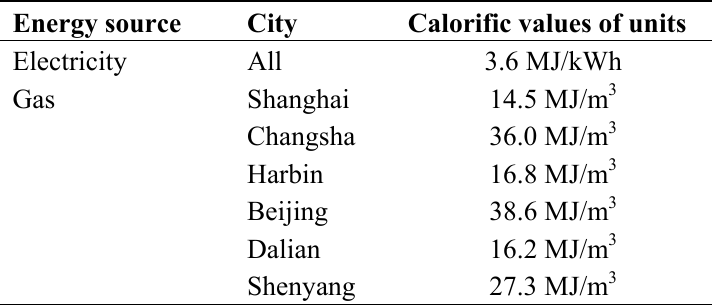
Table 3. Energy conversion values of energy sources.